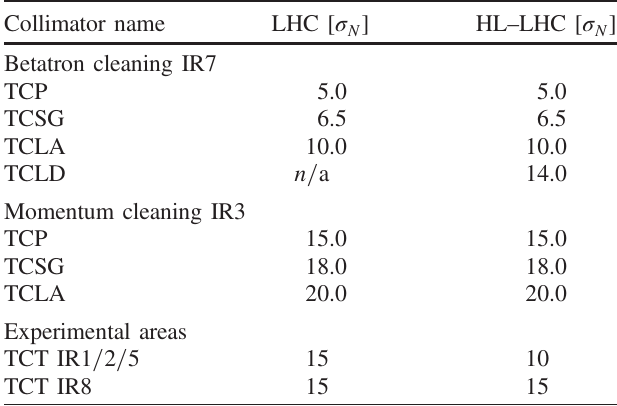
TABLE II. Summary of the collimator settings at top energy optics as used in the 2018 MD, as well as for the HL – LHC collision optics. The settings are given in units of the nominal one sigma beam size, σ N , expressed with respect to a proton- equivalent emittance of ε ¼ 3 . 5 μ m.